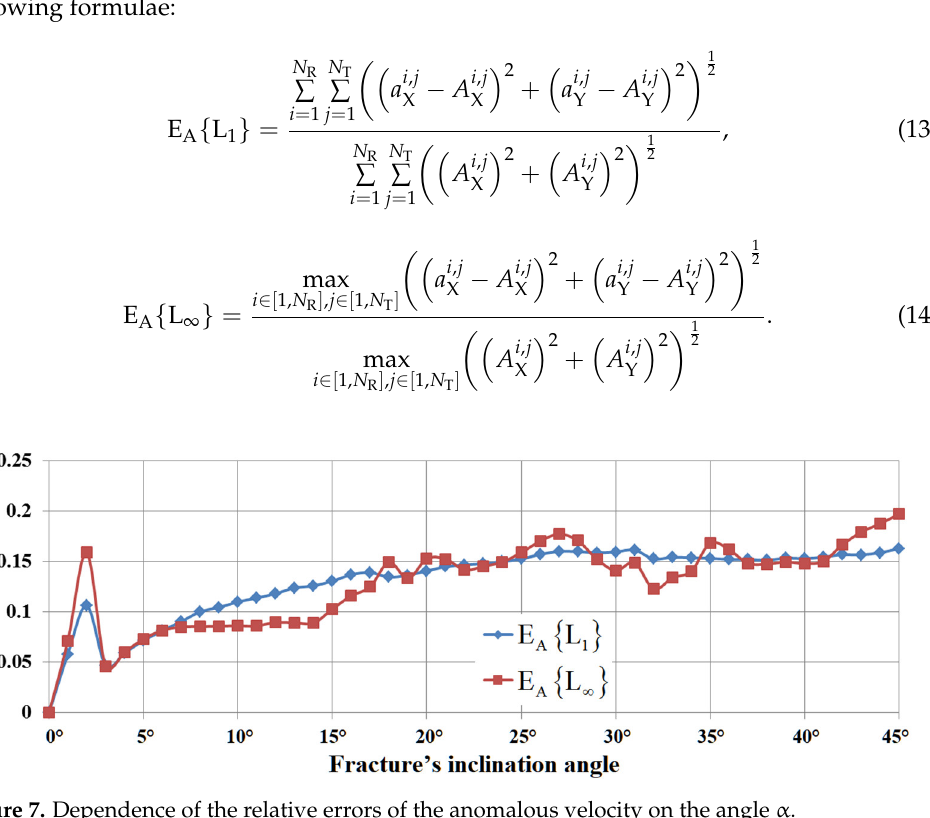
Figure 7. Dependence of the relative errors of the anomalous velocity on the angle α. In (13) and (14), a i , j , a i , j are the anomalous velocity field components calculated X Y using the proposed method of the original coordinate system; A i , j velocity field components of the calculated without an overlapping curvilinear mesh in the respectively rotated coordinate